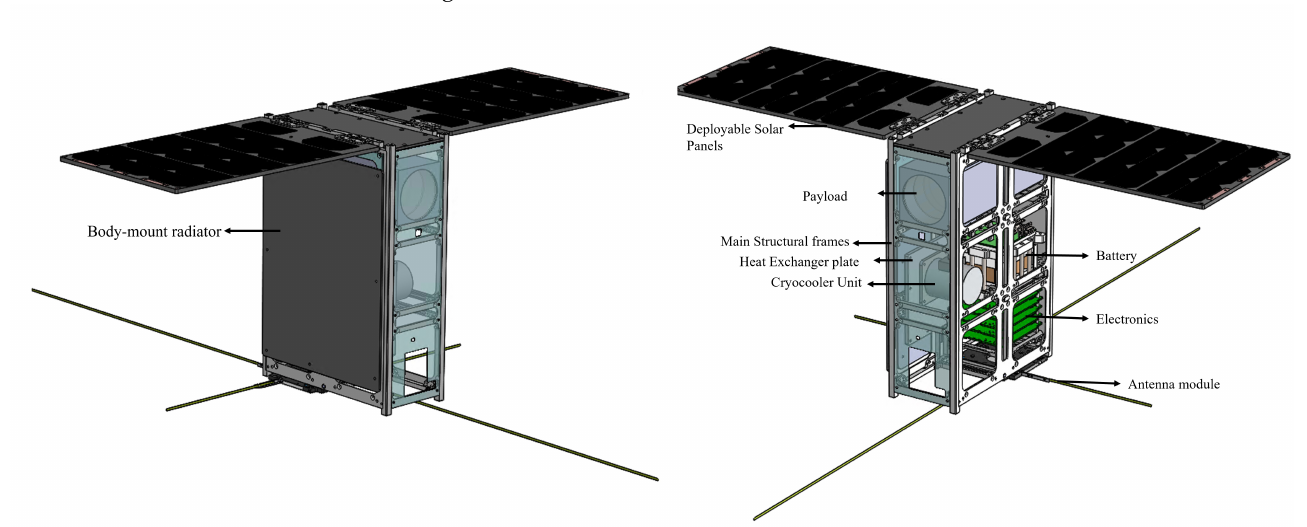
Figure 10. 6U—Mechanical design.